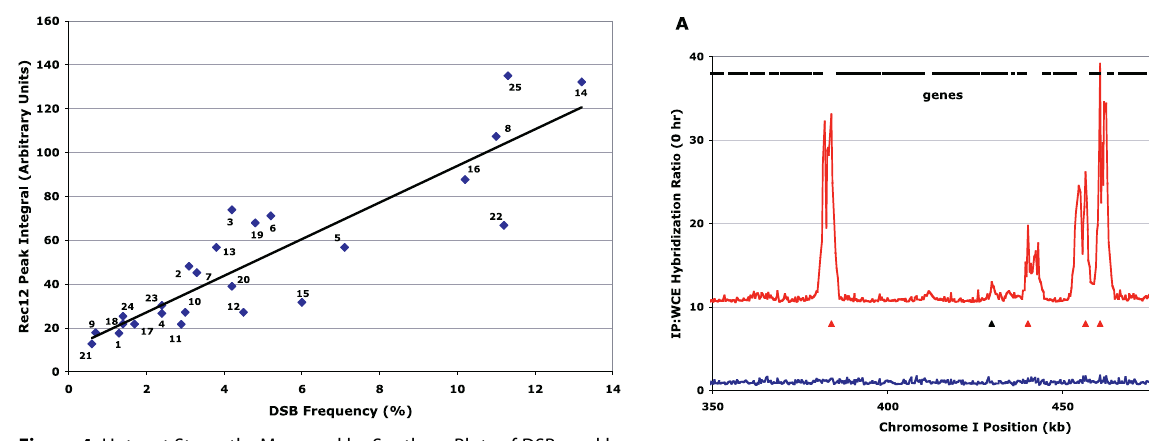
Figure 4. Hotspot Strengths Measured by Southern Blots of DSBs and by Microarray Data of Rec12-DNA Linkages Correlate Well The percent of total DNA broken at each of the 25 hotspots indicated by numbered black diamonds in Figure 3 is plotted versus the integral of the IP:WCE ratios for the corresponding peaks in the microarray data (mean of haploid and diploid experiments). The regression line is y ¼ 8.35 x þ 10.4.